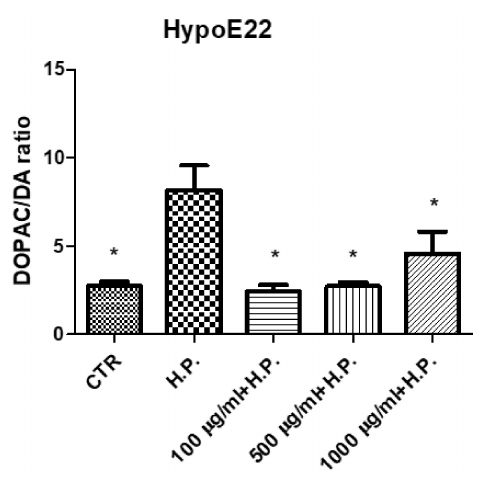
Figure 9. Inhibitory effects induced by Prunus mahaleb L. water extract (100–1000 µ g/mL) on hy- drogen peroxide (H.P.)-induced DA turnover (DOPAC/DA ratio). ANOVA, p < 0.001; * p < 0.05 vs. H.P. group.